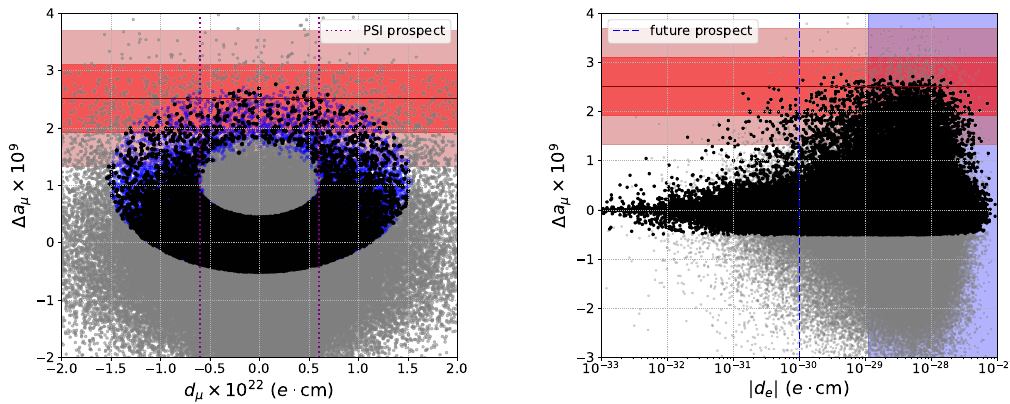
Figure 4 . The correlations of muon g − 2 with muon EDM (left plot) and electron EDM (right plot). The horizontal red line and (light) red bands correspond to the central value and (2 σ ) 1 σ regions of the observed muon g − 2 , respectively. The h → µ + µ − constraint is first applied in both plots and the sampling points which do not satisfy it are shown as the gray dots. In the left plot, we also show the sampling points further excluded by the electron EDM constraint in blue. The black dots are the points that satisfy both the constraints from h → µ + µ − and electron EDM. The vertical dotted line represents the PSI experiment. In the right plot, the blue band shows the constraint from electron EDM measurement and the vertical dashed line indicates the prospect of the near-future electron EDM